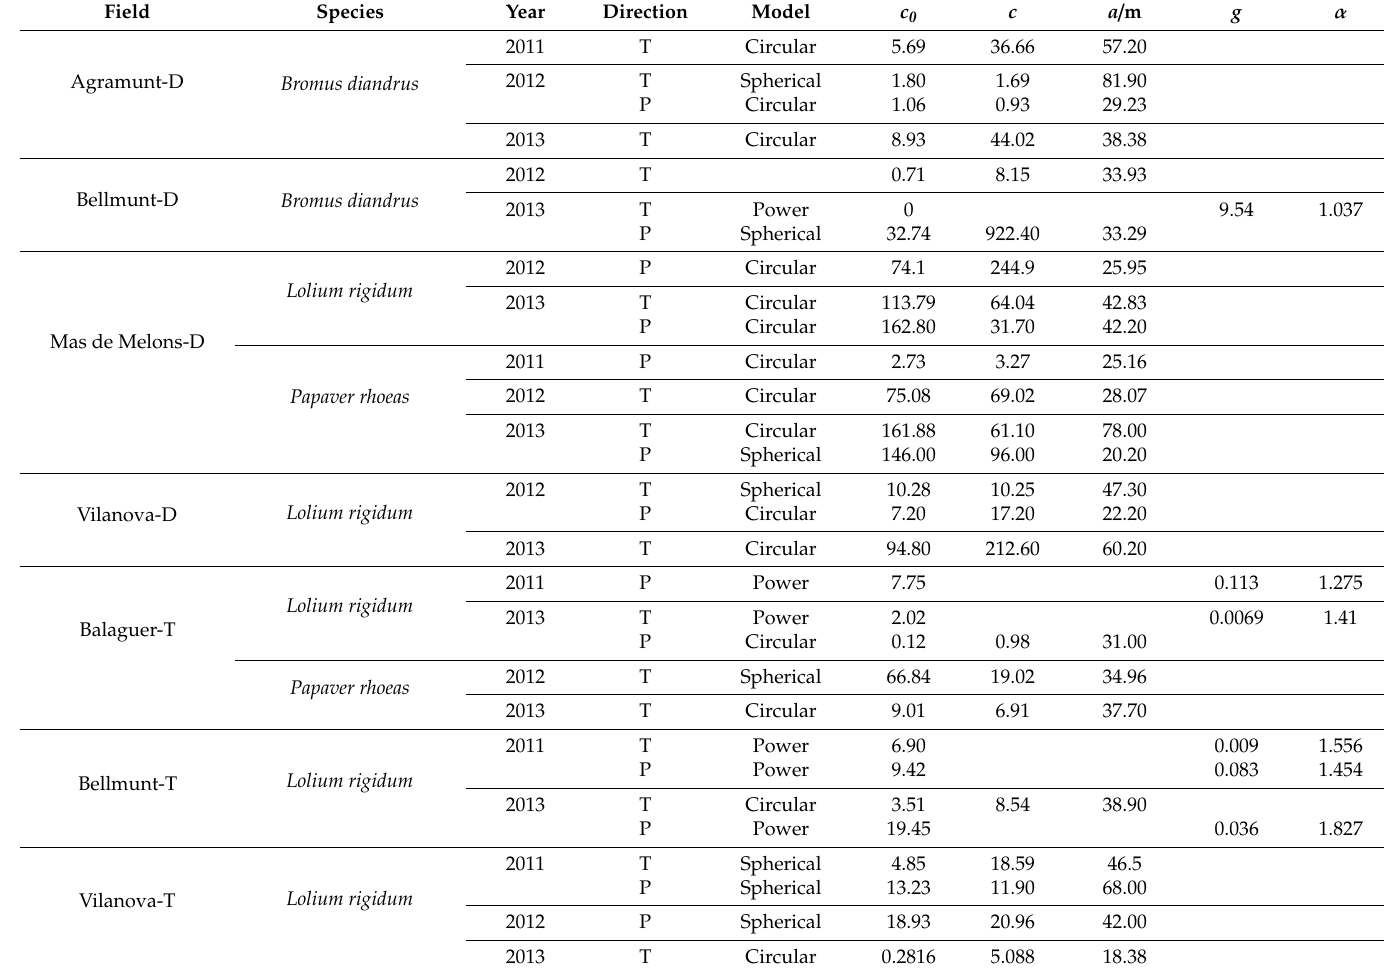
Table 4. Models fitted to the directional variograms (parallel, T, or perpendicular, P, to the field tra ffi c) of the weed cover, with their parameter values for direct-drill (D) and harrow tillage (T) fields. The parameters are: c 0 : nugget variance; c : sill; a : range; g : intensity of variation; α :